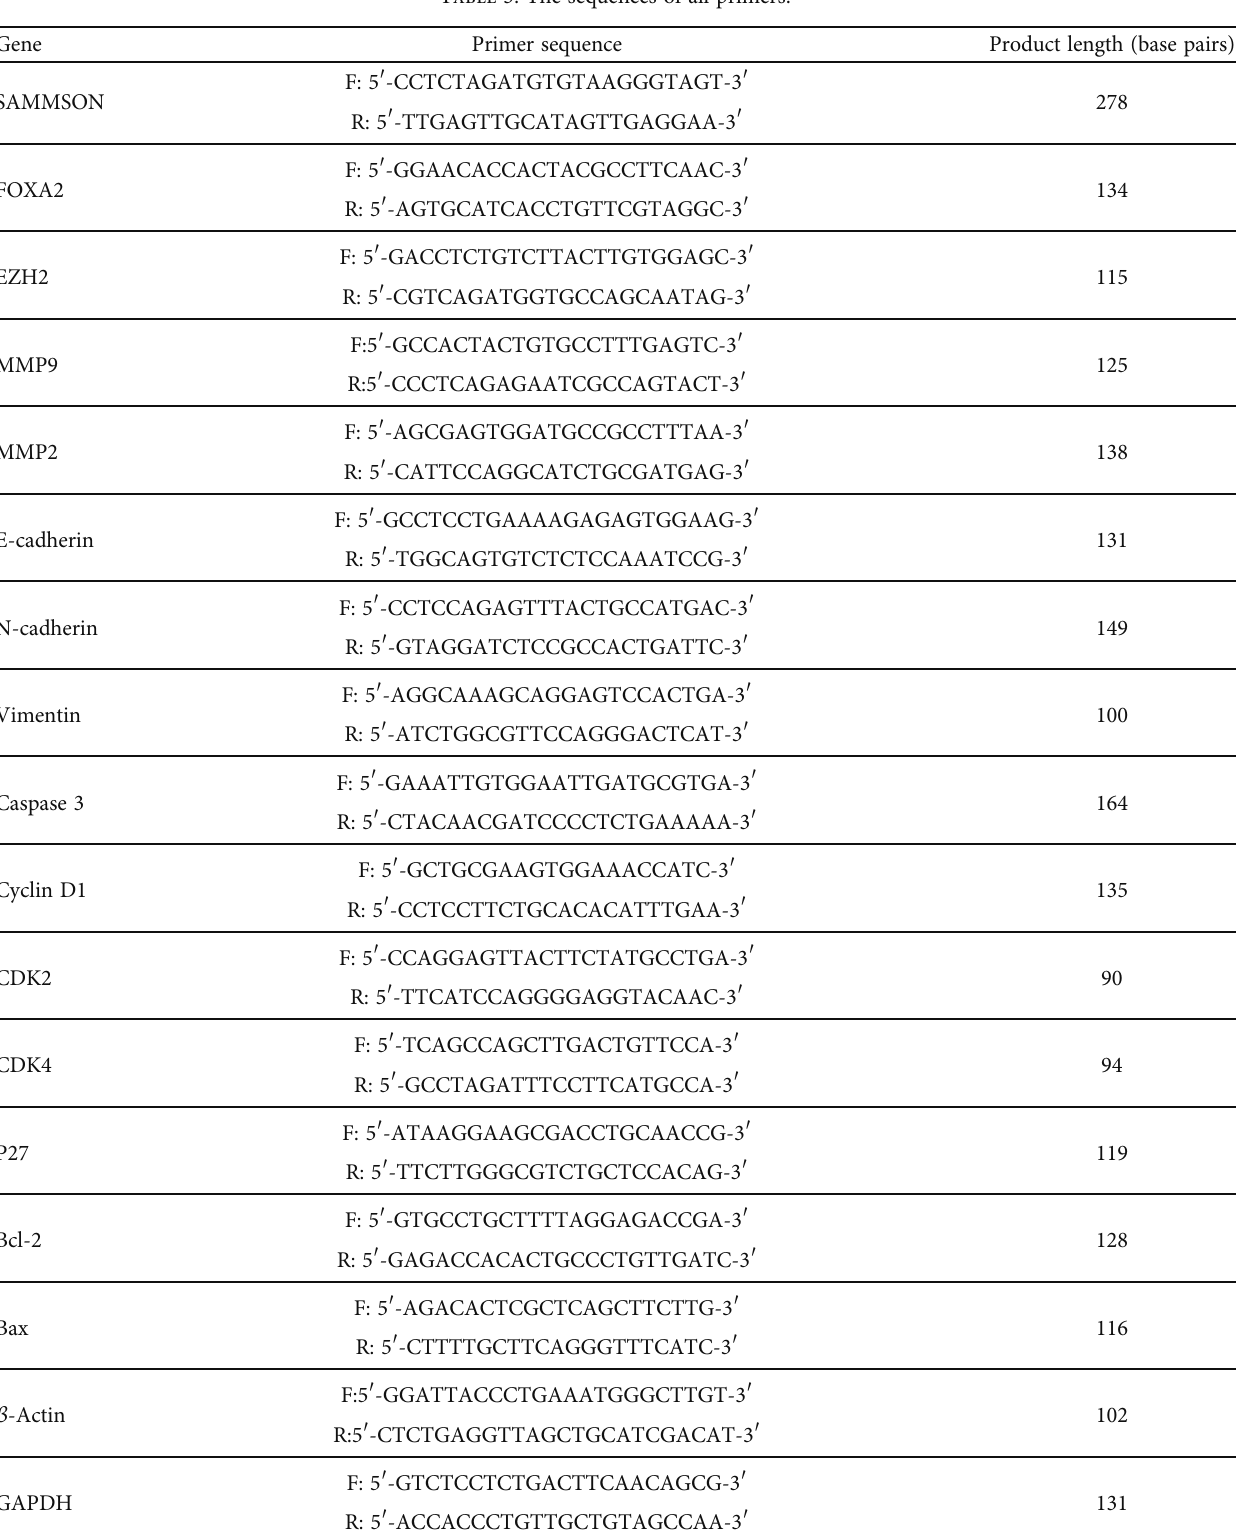
Table 3: The sequences of all